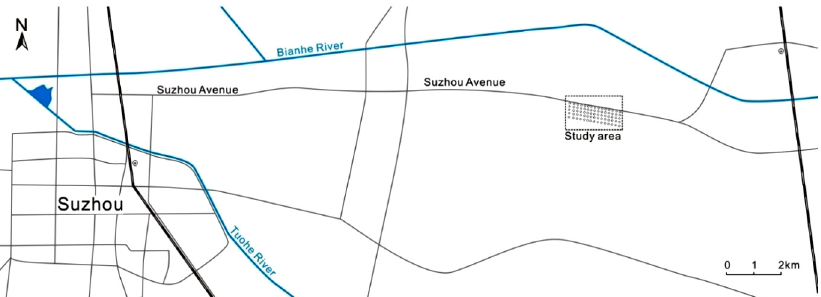
Figure 1. Location of the study area and sample distributions. Circles are the